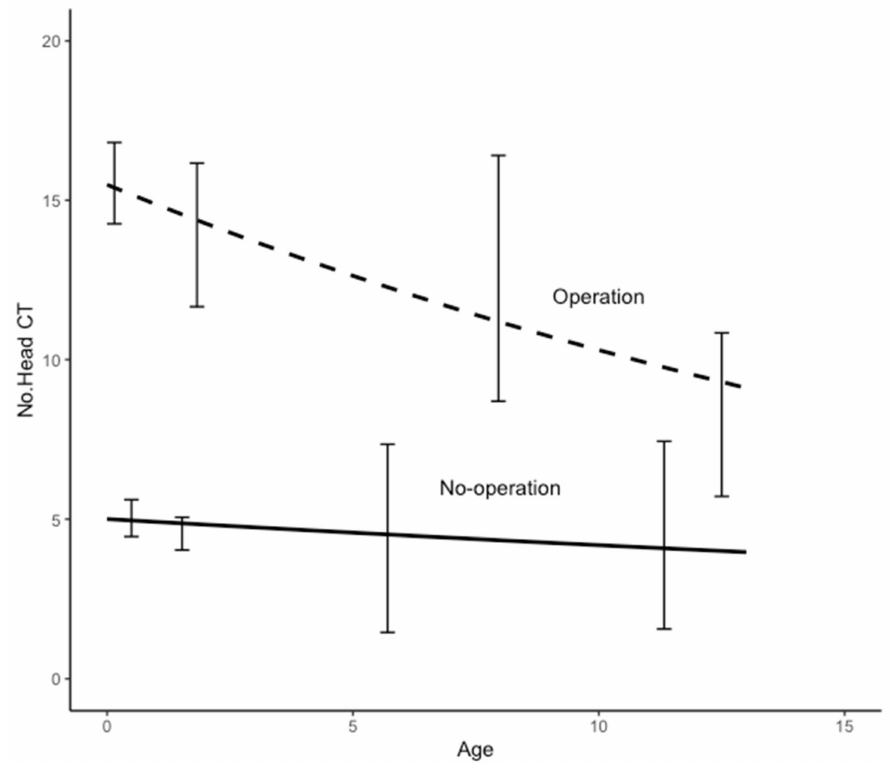
Figure 2. Age dependence of the number of CT examinations in hydrocephalus patients with and without surgery. The age is at the time of initial